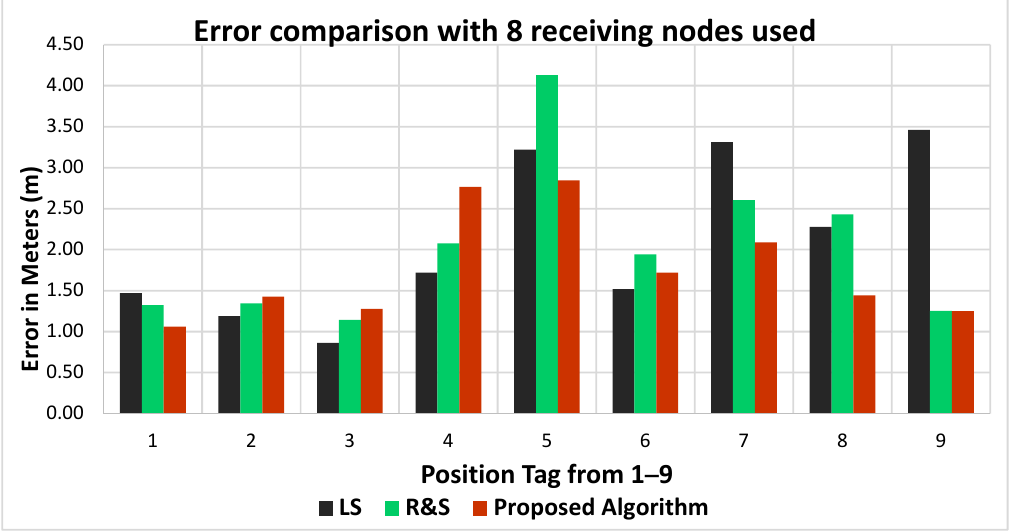
Figure 12. Error comparison with eight measurement sensors used.